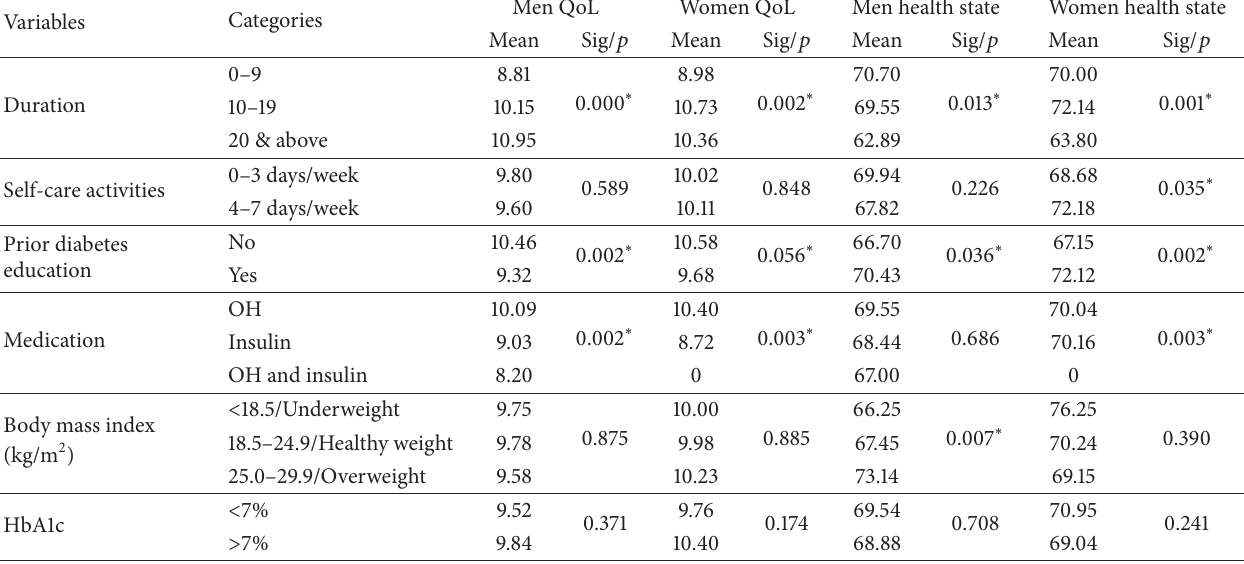
Table 3: Clinical characteristics and total QOL and health state among men and women.